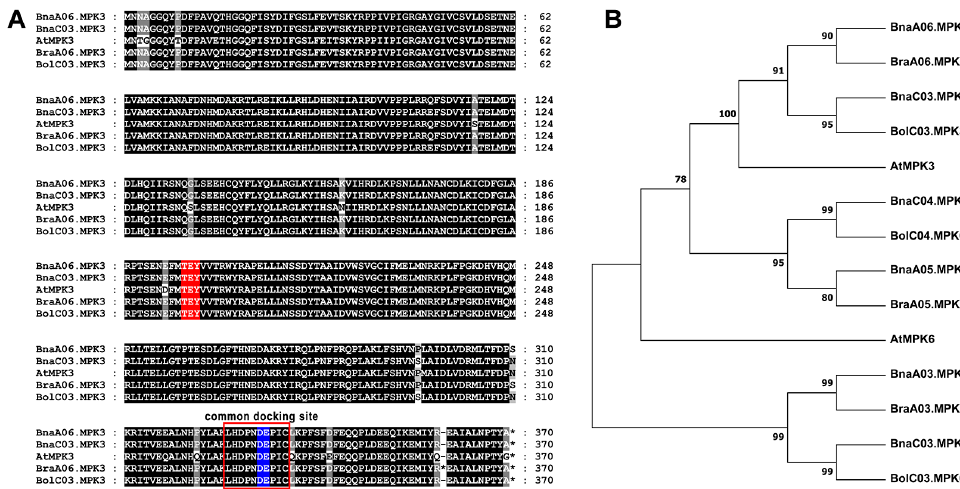
Figure 3. Sequence alignment and phylogenetic tree construction of Brassica MPK3. ( A ) Amino acid sequence alignments of identified MPK3 copies in Brassica and Arabidopsis. The conserved amino acid residues are shown in black shading and similar residues are displayed in gray shading. TEY motif is marked with red; common docking site is marked with red square frame, and two adjacent acidic residues are highlighted in blue. Bra, Brassica rapa ; Bol, Brassica oleracea. ( B ) Phylogenetic analysis showing the relationship between each copy of B. napus MPK3 and MPK3/MPK6 in Brassica species, as well as MPK3/MPK6 in Arabidopsis .